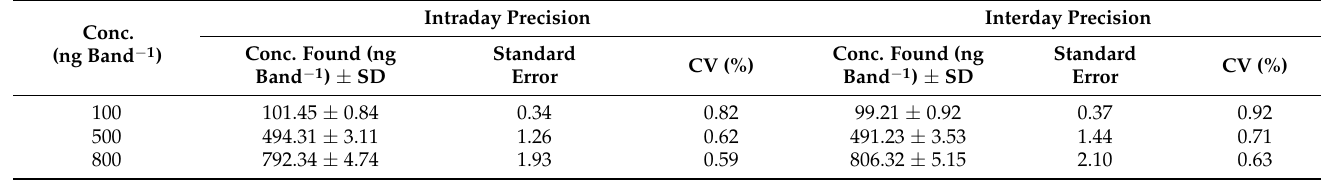
Table 4. Precision assessment findings of caffeine for the green HPTLC method (mean ± SD; n = 6).